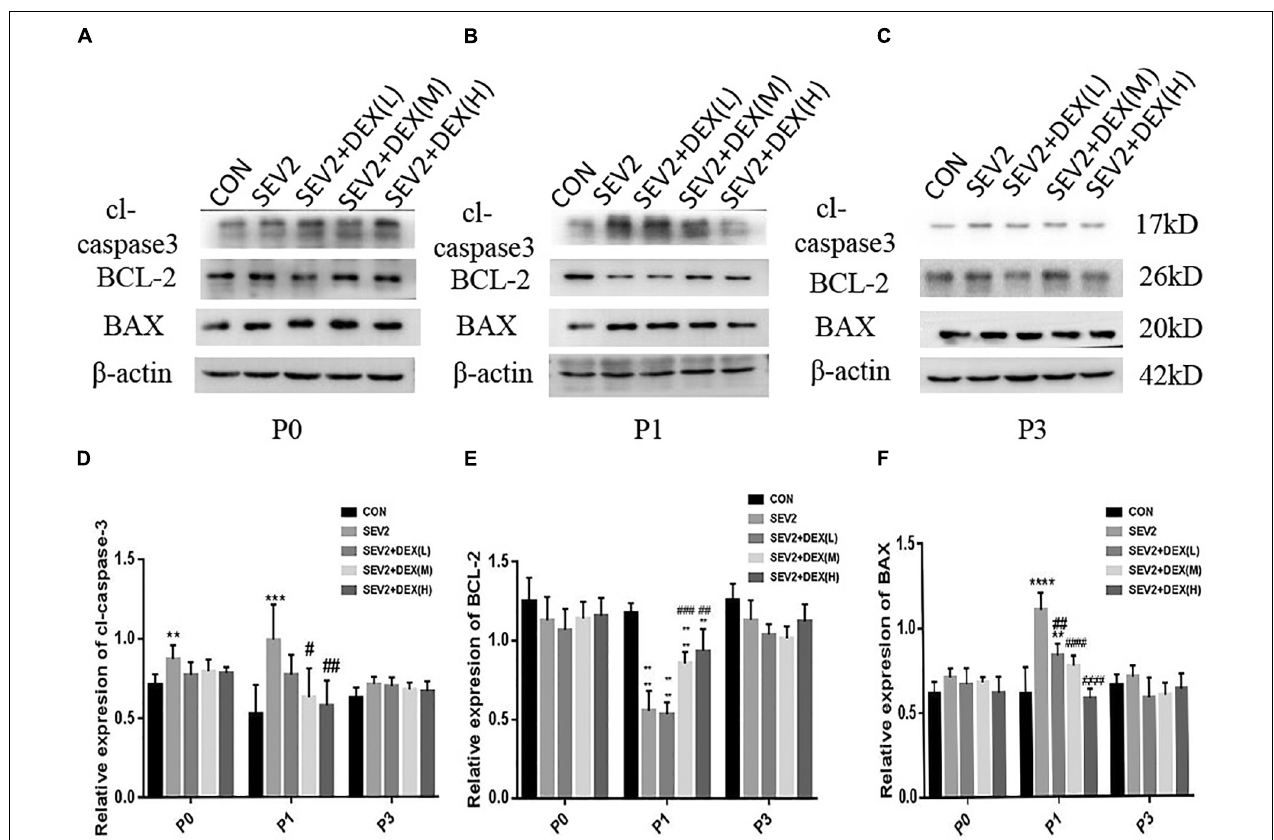
FIGURE 2 | Dex reduced apoptosis induced by maternal sevoflurane anesthesia in a dose-dependent manner in the hippocampus in the offspring rats. Representative Western blots for the expression levels of cl-caspase3, BCL-2, and BAX at P0 (A) , P1 (B) , and P3 (C) rat hippocampus. Quantification of cleaved-caspase3 (D) , BCL-2 (E) , BAX (F) normalized to β -actin. Data are expressed as the mean ± SEM ( n = 6 in each group). Results comparisons were made using one-way ANOVA and post hoc Tukey’s correction. ∗∗ P < 0.01, ∗∗∗ P < 0.001, ∗∗∗∗ P < 0.0001, compared to the CON group; # P < 0.05, #### P < 0.01, ### P < 0.001, #### P < 0.0001, compared to the SEV2